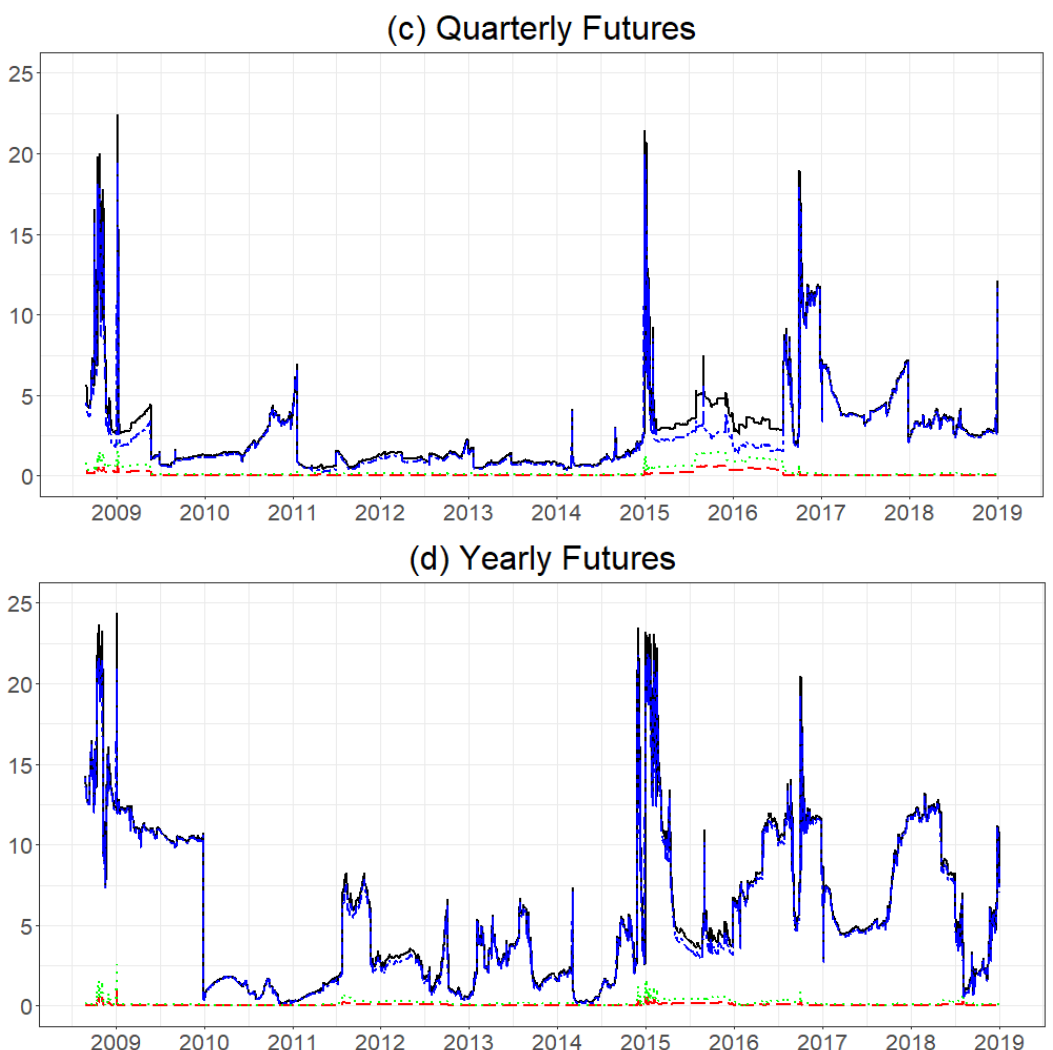
Figure 4. Diebold–Yilmaz approach (2012) directional volatility spillover (From) and Barunik–Krehlik methodology (2018) directional volatility spillover (From). Note: spot: EPEX Germany Baseload Spot; monthly futures: EEX Germany Baseload Monthly Futures; quarterly futures: EEX Germany Baseload Quarterly Futures; yearly futures: EEX Germany Baseload Yearly Futures.